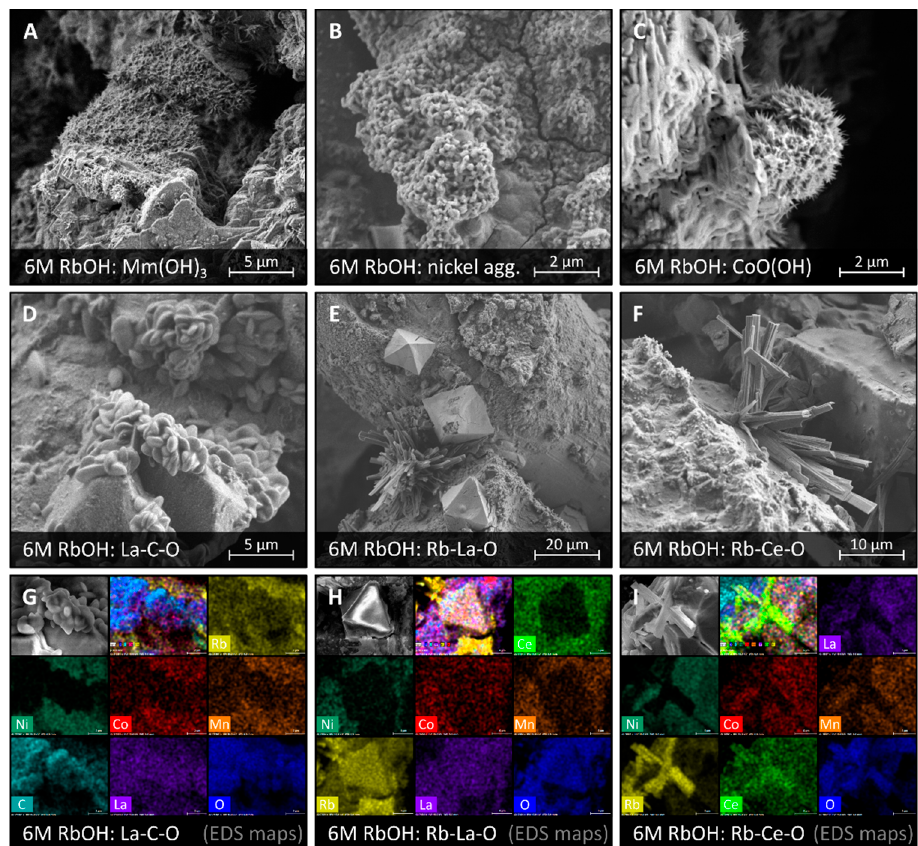
Figure 2. SEM images of a surface of LaMm-Ni 4.1 Al 0.3 Mn 0.4 Co 0.45 alloy after electrochemical treatment in 6 M RbOH showing surface formations of: Mm(OH) 3 ( A ), nickel aggregations ( B ), CoO(OH) ( C ), La-C-O ( D ), Rb-La-O ( E ), and Rb-Ce-O ( F ). EDS maps showing elemental distribution in the areas